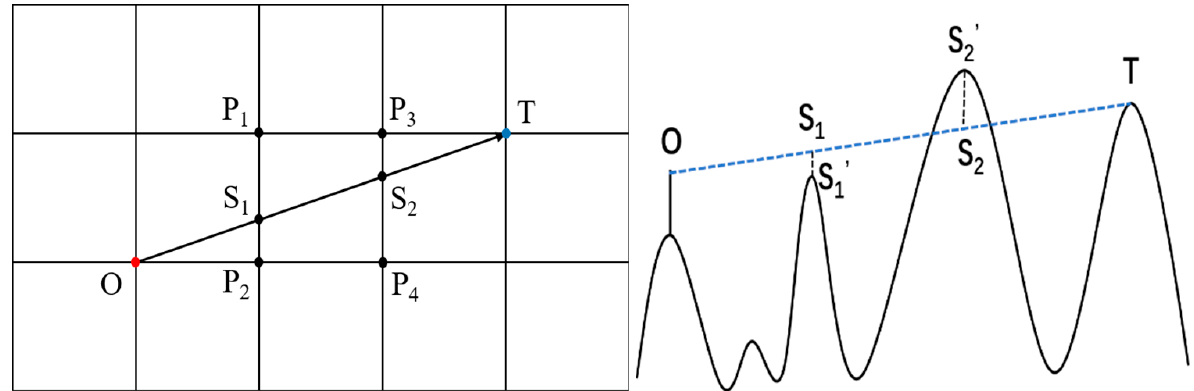
Figure 2. A common algorithm for visual domain analysis based on line of sight ( left ). Schematic diagram of occlusion in elevation direction ( right ).